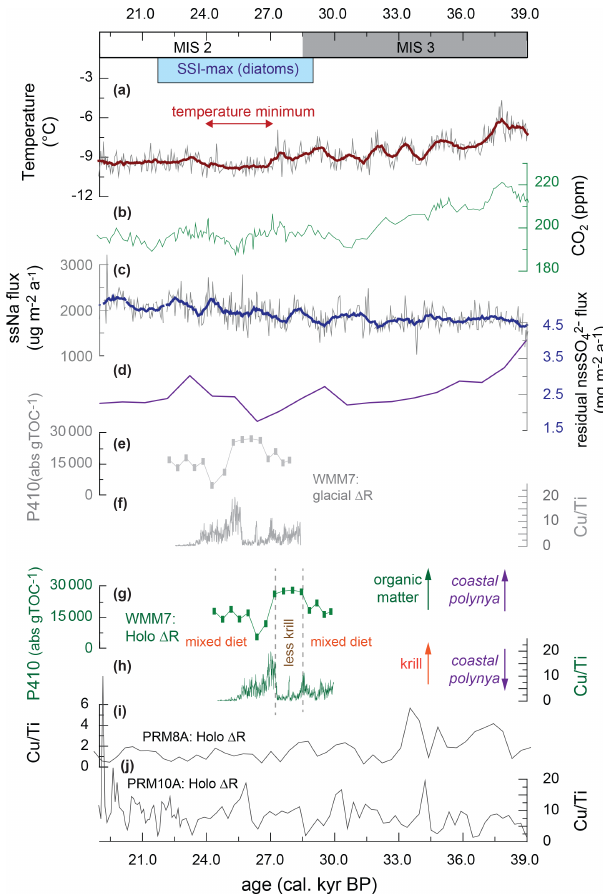
Figure 6. Variations in snow petrel diet across the MIS 3–2 tran- sition, including the interval of maximum summer sea-ice extent (SSI-max) in the Scotia Sea from Allen et al. (2011) and plotted in Fig. 1. (a) Air temperature recorded by δD in an EPICA–DML ice core (Jouzel et al., 2007); (b) atmospheric CO 2 from a West Antarctic Ice Sheet (WAIS) ice core (Bauska et al., 2021); (c) sea- salt Na flux from an EPICA–DML ice core (Fischer et al., 2007); (d) biogenic sulfate flux to the EPICA–DML ice core, generated by correcting for terrestrial contributions to non-sea-salt Na flux (Goto-Azuma et al., 2019); (e) WMM7 chlorin pigment abundance plotted using the glacial-stage (enhanced sea ice) (cid:49)R from Table 1; (f) WMM7 Cu / Ti ratio plotted using the glacial-stage (enhanced sea ice) (cid:49)R from Table 1.; (g) WMM7 chlorin pigment abundance plotted using the Holocene (low or absent sea ice) (cid:49)R from Ta- ble 1, as shown in Fig. 4; (h) WMM7 Cu / Ti ratios plotted using the Holocene (low or absent sea ice) (cid:49)R from Table 1, as shown in Fig. 3. As discussed in the text, we prefer to apply the Holocene (cid:49)R calibrations of (g, h) and interpret high chlorin values (g) as in- dicative of an enhanced phytoplankton and/or reduced krill signal, whereas high Cu / Ti ratios (h) are interpreted as evidence of en- hanced krill inputs. As discussed in the text, we infer the loss of krill from the snow petrel diet at ∼ 27–28ka to represent polynyas open- ing over the continental shelf. (i, j) Cu / Ti signals in other DML stomach-oil deposits from analysis in Berg et al. (2019) recalibrated using the Holocene (cid:49)R from Table